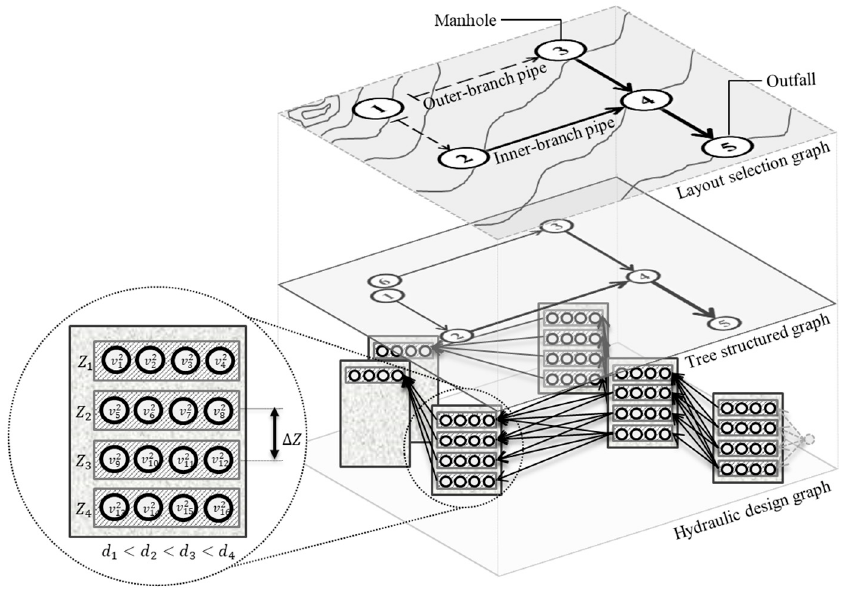
Figure 1. Relationship of the three sewer network design problem graphs. The layout selection graph (top) represents the network topology. The tree-structured graph (middle) is the representation of the layout as a tree-like open network by using additional nodes to represent all the manholes at the extremes of the branches. Finally, the hydraulic design graph (bottom) defines the hydraulic design options following the tree-structured graph’s connectivity.